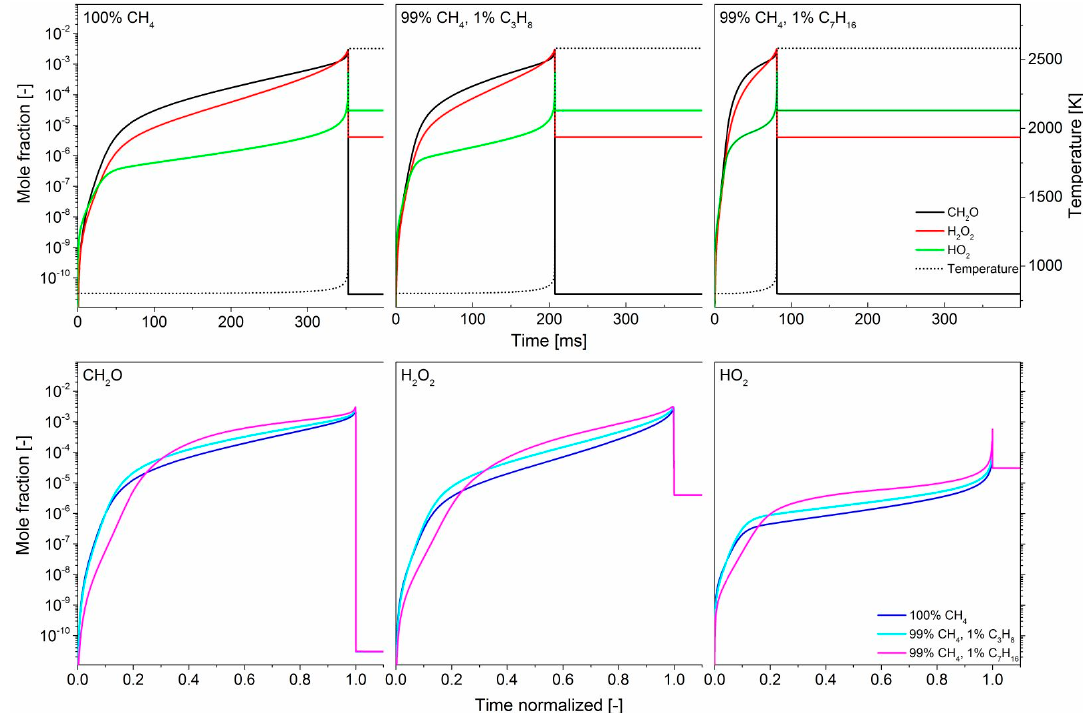
Figure 13. Development of the species formaldehyde (CH 2 O), hydrogen peroxide (H 2 O 2 ) and hydroperoxyl radicals (HO 2 ) prior to ignition for a methane-air mixture ( top , left ), methane-air mixture with 1 mol % propane addition ( top , middle ) and methane-air mixture with 1 mol % n-heptane addition ( top , right ). The lower part of this figure shows the species development as a function of the time normalized to the IDT. The simulations were performed at 800 K gas temperature, λ = 1.43 and a pressure of 60 bar using the mechanism of Mehl et al.